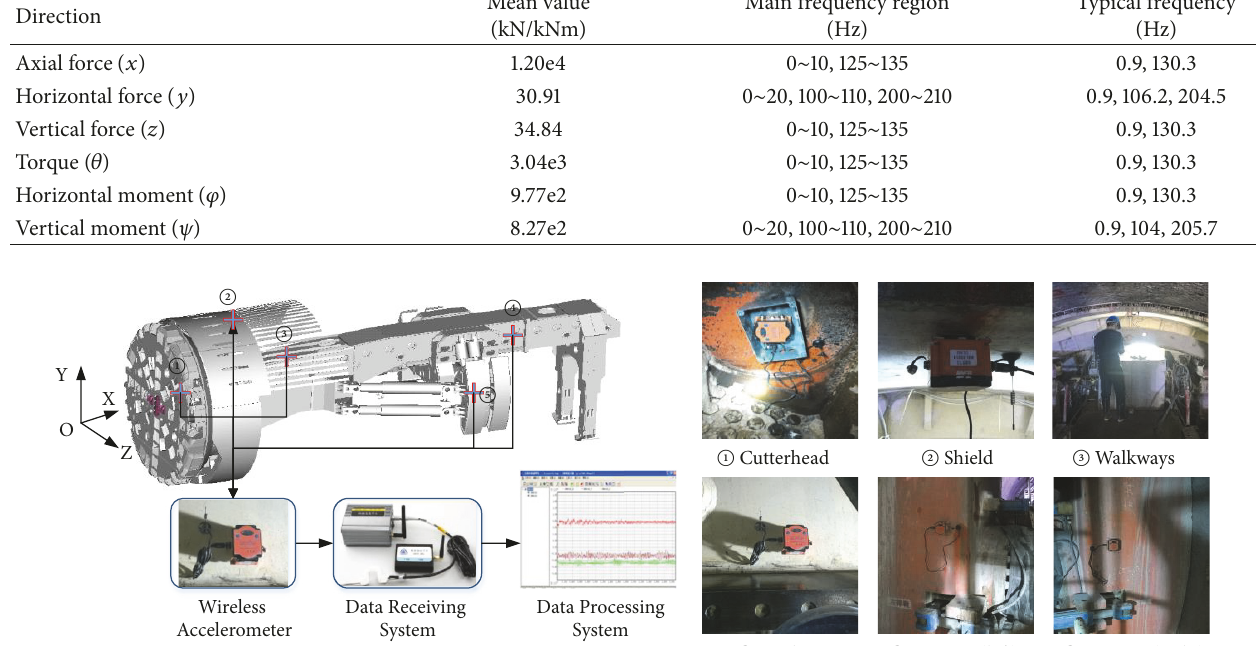
Figure 6: Schematic diagram of vibration testing in the tunneling field of TBM.